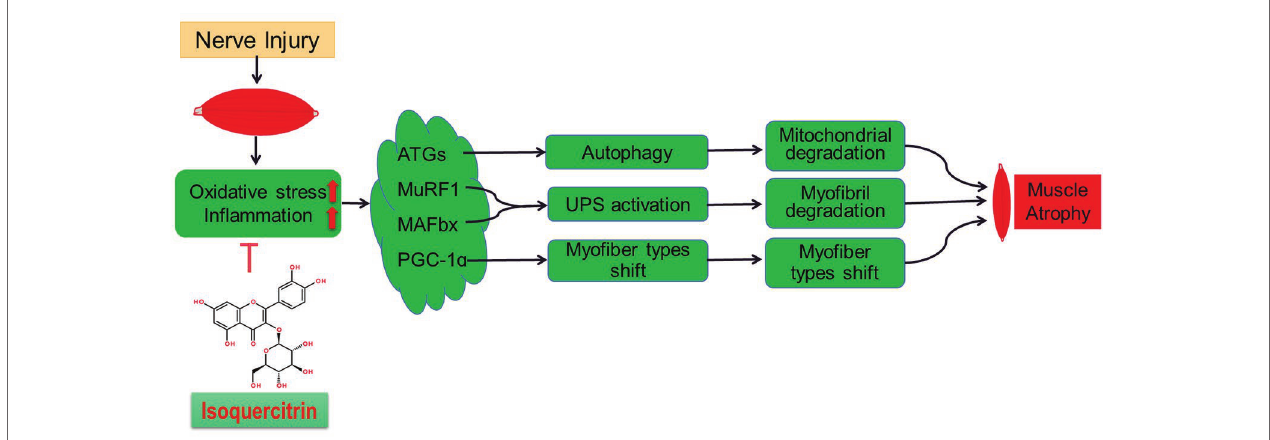
FIGURE 7 | A schematic diagram illustrating the proposed mechanism by which peripheral nerve injury induces soleus muscle atrophy. Denervation-induced skeletal muscle atrophy is associated with oxidative stress and inflammation. The inhibition of oxidative stress and inflammation through Isoquercitrin alleviated denervation-induced skeletal muscle atrophy by reducing proteolysis, inhibiting mitophagy, and reversing the slow-to-fast fiber type conversion following